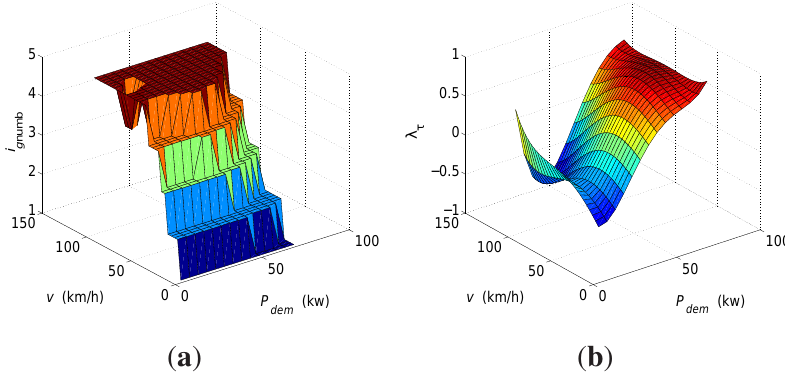
Figure 8. Decision maps, ζ = 0 . 33 . ( a ) Gear number map; ( b ) torque split ratio